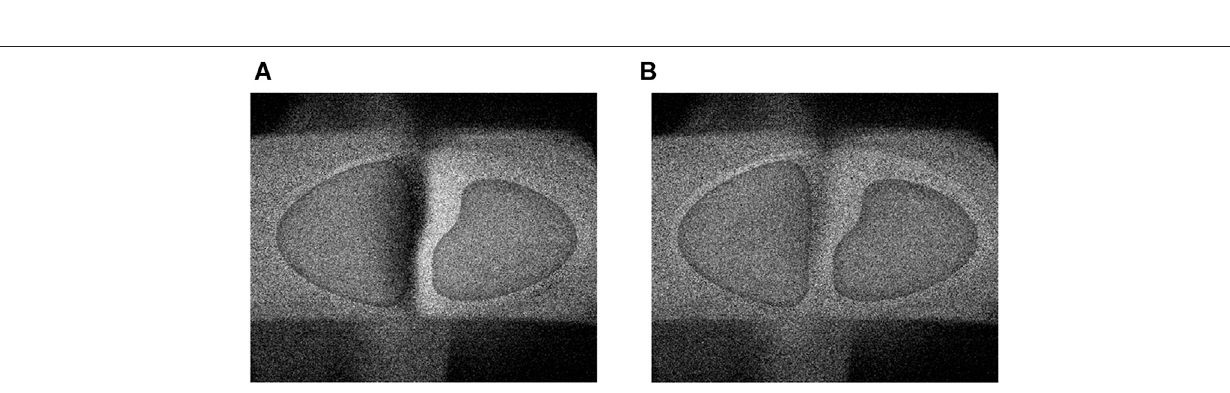
FIGURE 7 | A schematic illustration of the experimental setup for ethanol gas detection using the wedge-shaped Au thin fi lm. Inset is a photograph of the sensing chip and gas inlet tube.